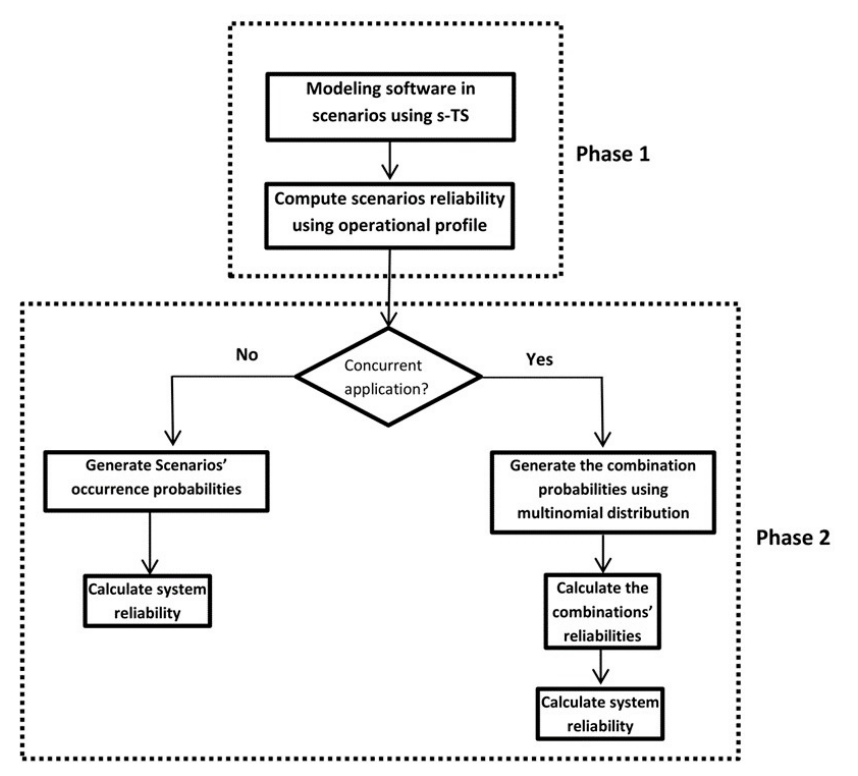
Figure 1. The proposed model’s phases and